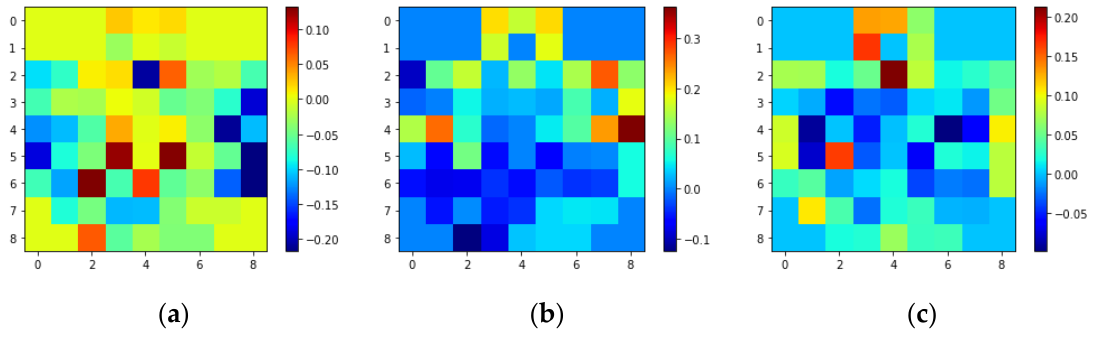
Figure 4. 2D 9 × 9 EEG frame samples of different emotions of SEED: ( a ) Positive; ( b ) Neutral; ( c ) Negative.